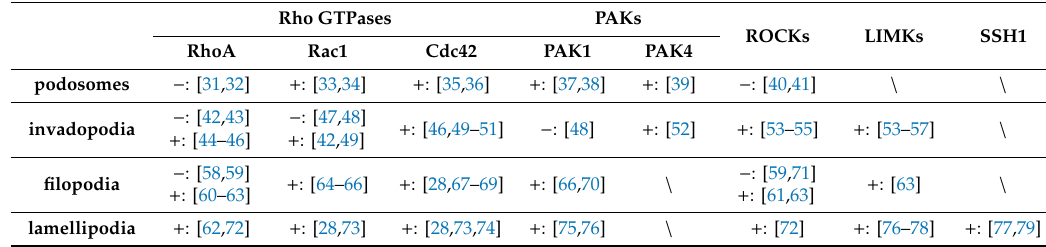
Table 1. Cellular structures regulated by actin cytoskeleton regulatory